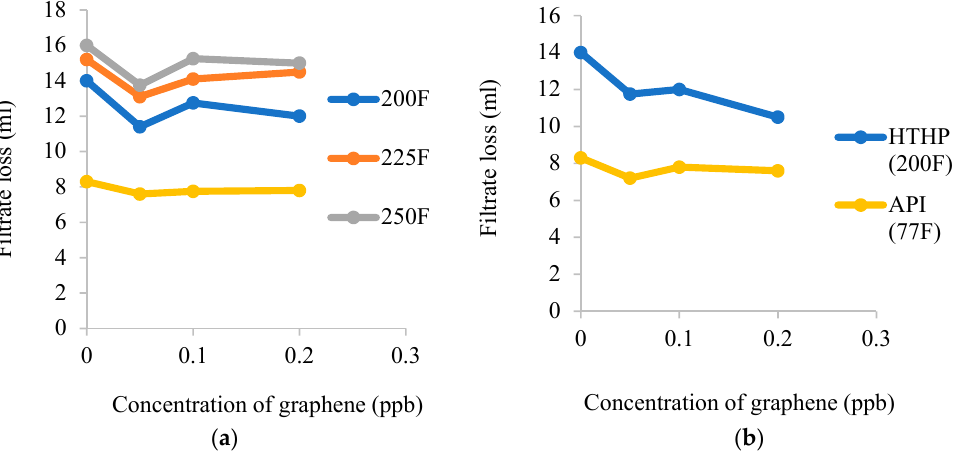
Figure 4. High pressure-high temperature (HPHT) filtrate loss at different concentrations of ( a ) commercial graphene and ( b ) waste graphene. Reproduced with permission from [61]. Copyright IOP Publishing, 2020.